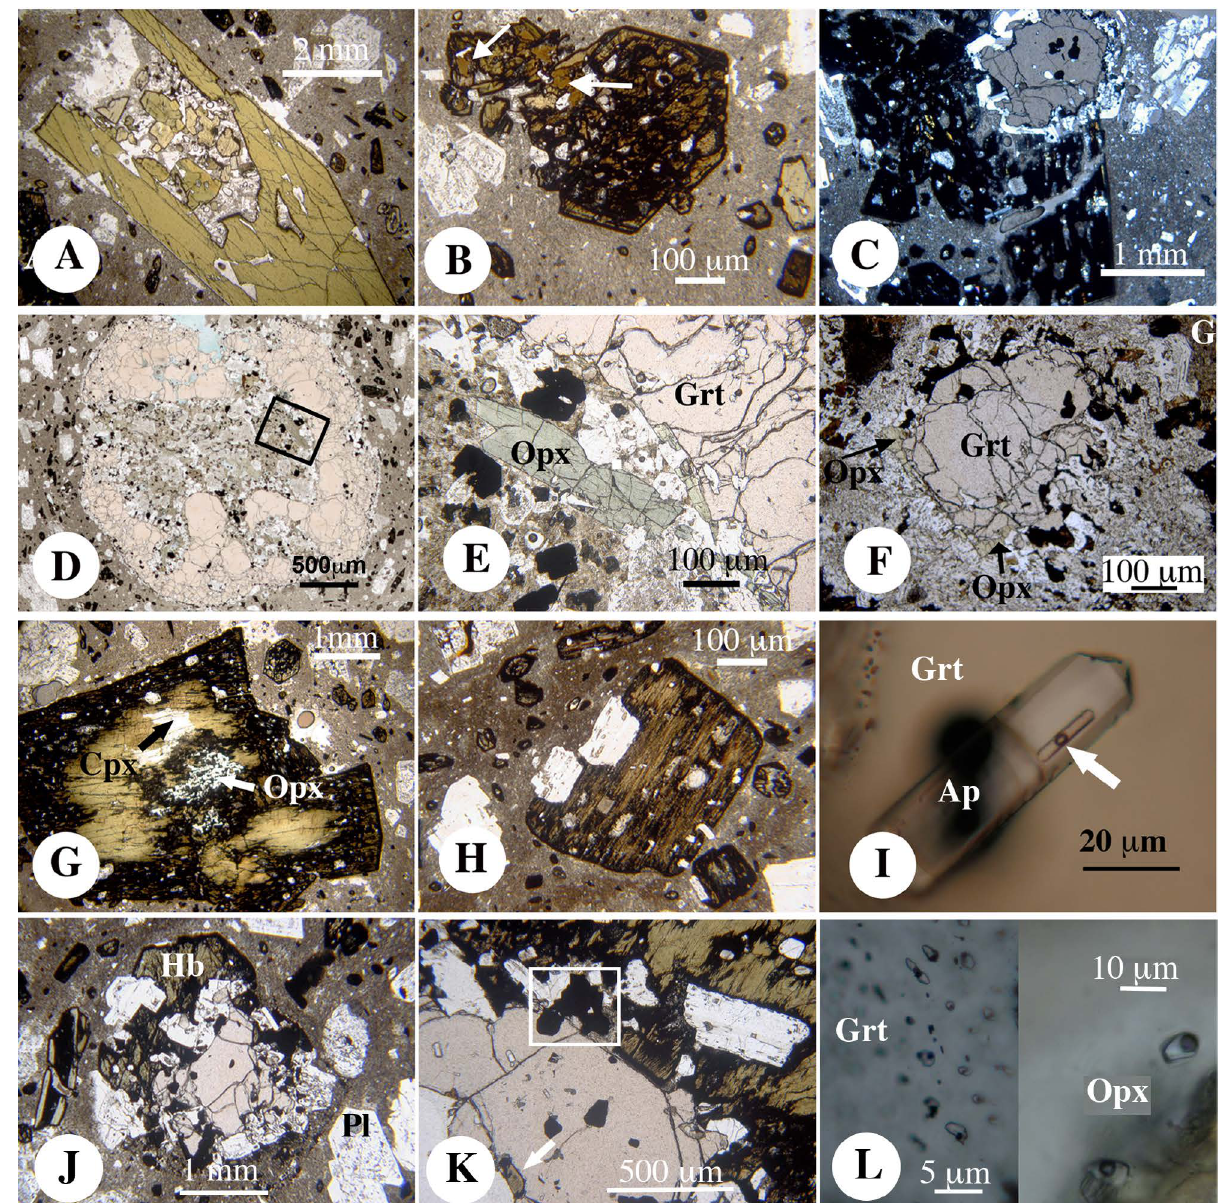
Figure 4: Transmitted light photomicrographs of the main phases. Mineral abbreviations after Whitney and Evans [2010]. [A] Perfectly euhedral green hornblende phenocryst almost devoid of any reaction-rim. [B] Brown horn- blende phenocryst with biotite inclusions (arrows). [C] Photomicrograph (partly crossed polariser) of a “brown- black” hornblende phenocryst almost totally transformed in opacite. Partly enclosed garnet crystal shows a pla- gioclase corona, attesting that it was in contact with the melt and developed a reaction-rim before being enclosed by amphibole. [D] General view of the atoll-like garnet megacryst described in the text. Black box corresponds to the enlarged view in Figure 4E. Thin-section scan, width of view 20 mm. [E] Boxed area in Figure 4D. Orthopyroxene crystal in the central cavity of the atoll-like garnet. [F] Garnet-orthopyroxene association in the reaction-rim of a metasedimentary inclusion. The Ca-poor colourless core of the garnet is clearly visible. Groundmass is visible at upper right of the photograph. [G] Complex amphibole, with corroded remnants of ortho- and clinopyroxene in the core. [H] Rounded, partly resorbed biotite phenocryst. [I] Euhedral crystal of apatite included in garnet, showing a negative crystal-shaped melt inclusion with its typical shrinkage bubble (arrow). The black spot in the centre of the photograph corresponds to an ilmenite inclusion situated at a higher level. [J] Crystal clot of brown hornblende, garnet and plagioclase. The residual aspect of garnet is clearly visible. [K] Only known example of inclusion of brown hornblende in garnet (white arrow), indicating that both minerals could in some cases actually co-crystallise. White box corresponds to the Ti-oxides aggregate shown in Figure 5C. [L] Examples of the scarce and tiny melt inclusions respectively found in garnet (left) and orthopyroxene